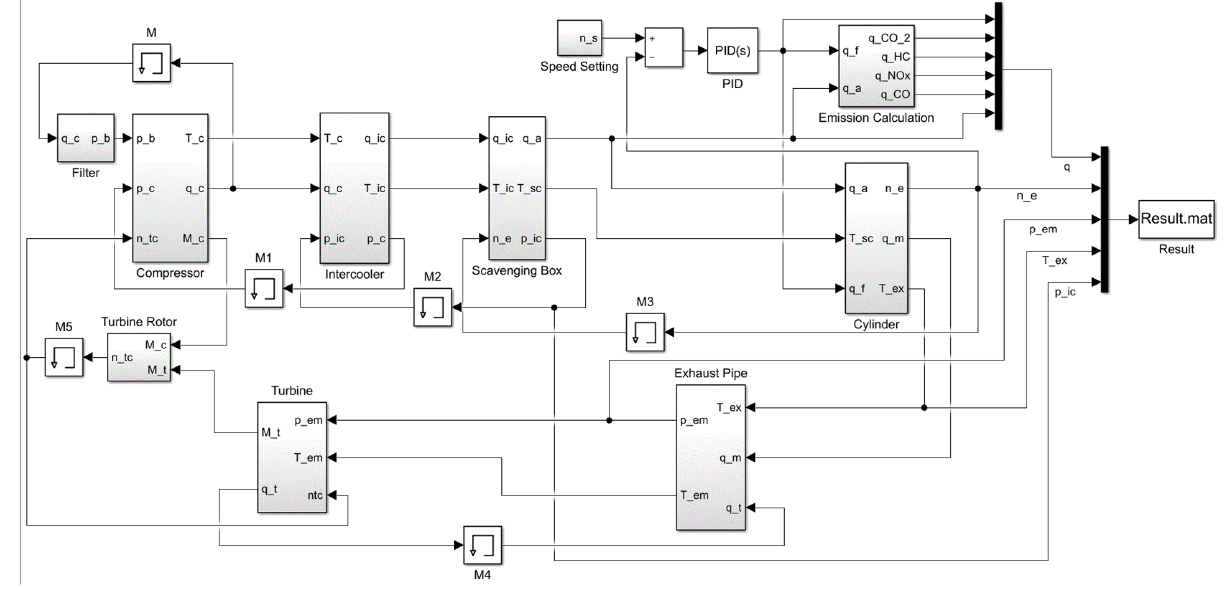
Figure 2. Simulation diagram of diesel engine in Simulink.